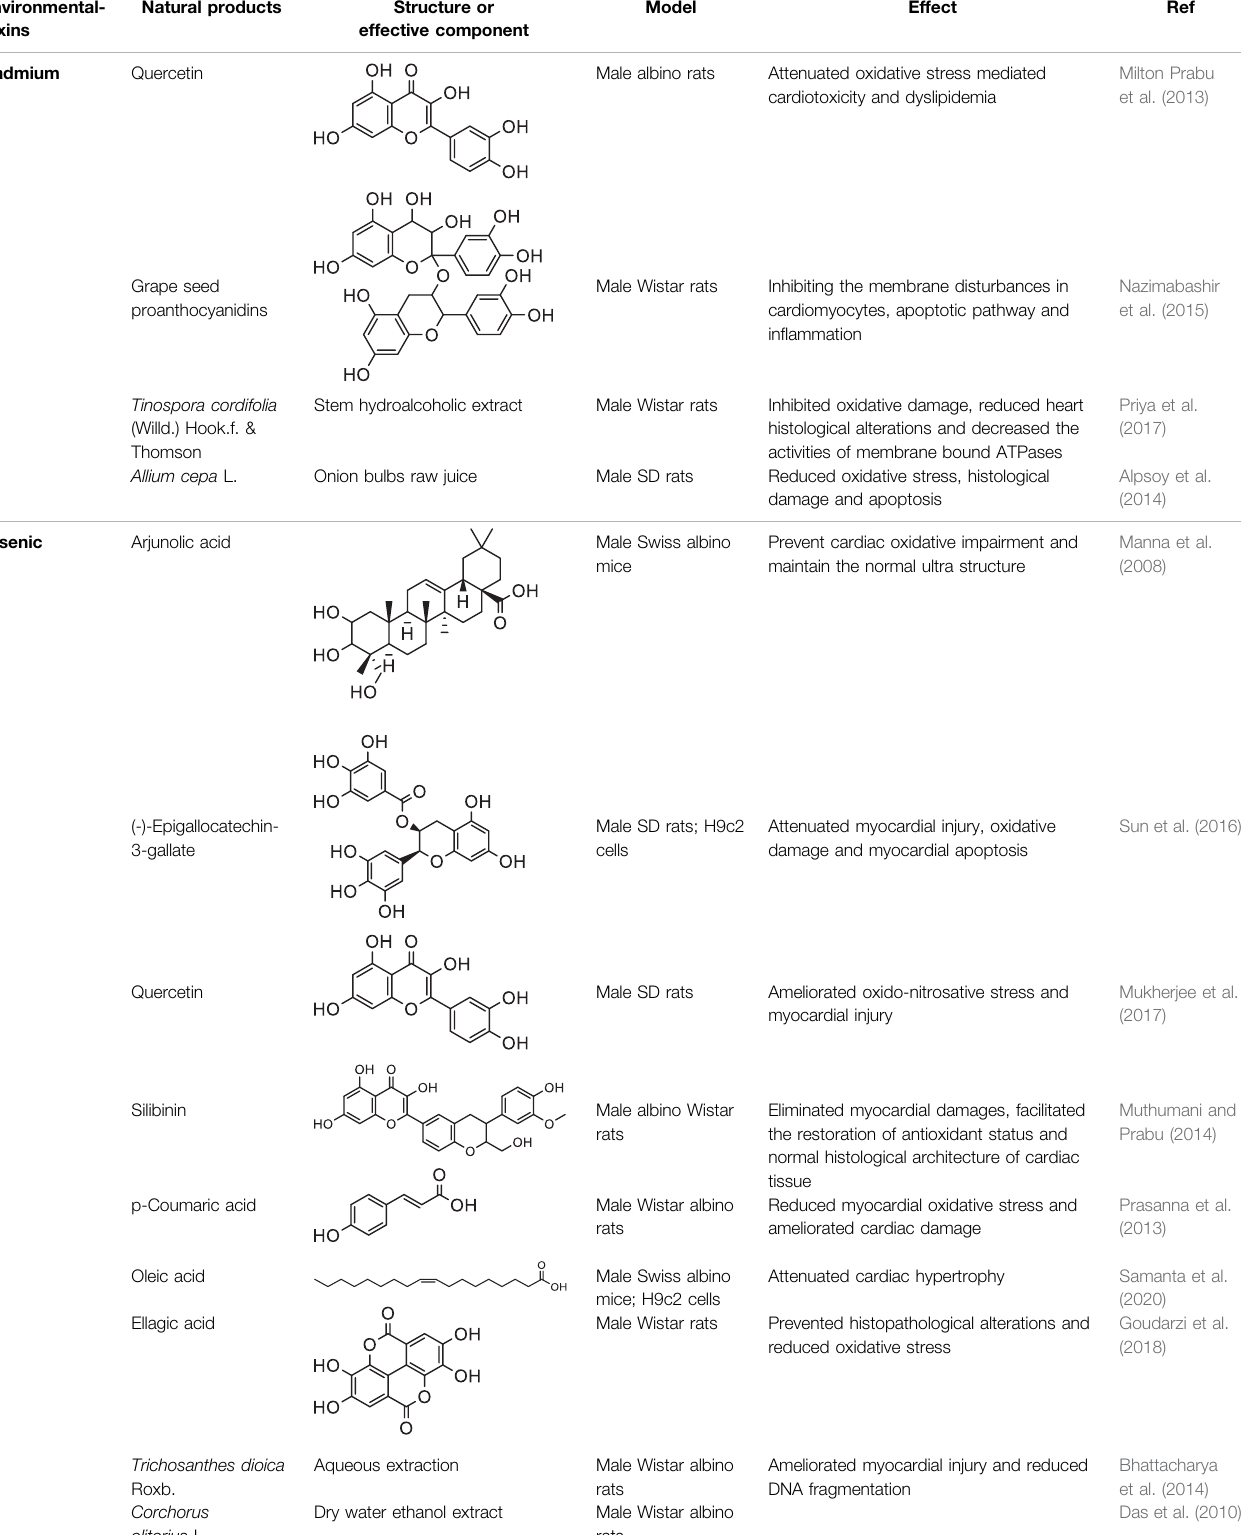
TABLE 1 | Protective effect of natural products against environmental toxins-induced